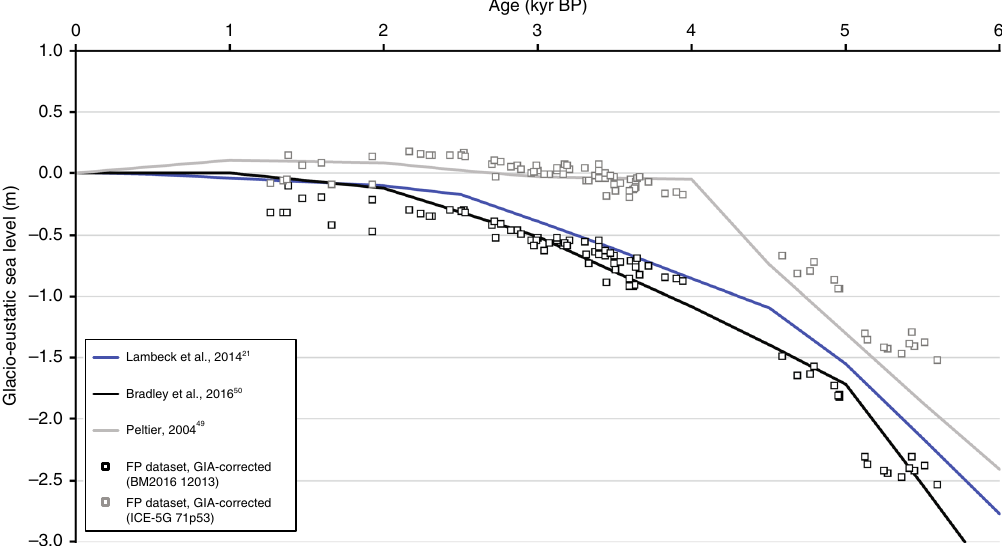
Fig. 8 Comparison of glacio-eustatic sea-level change estimates. Glacio-eustatic sea-level changes (changes in ice volume only) as represented in BM2016 (in black) and ICE-5G (in grey). Observations (black and grey squares) corrected for GIA based on the best- fi tting model (in black: BM2016; LT = 120 km; UMV = 10 21 Pa.s; LMV = 3 × 10 21 Pa.s; in grey: ICE-5G; LT = 71 km; UMV = 0.5 × 10 21 Pa.s; LMV = 3 × 10 21 Pa.s). Glacio-eustatic history inferred by Lambeck et al. 21 is shown in